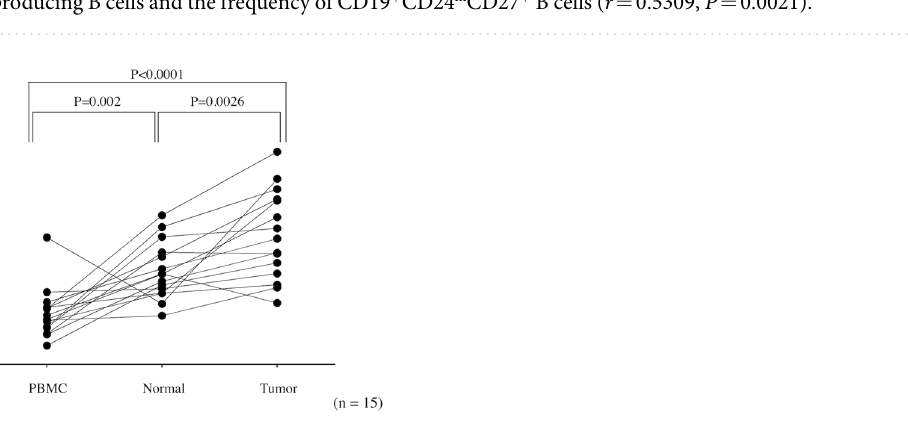
Figure 3. ( A ) Representative image of the frequency of regulatory B cells according to CD24 and CD27 expression in gastric cancer patients. ( B ) The frequency of IL-10-producing B cells in (a) CD19 + CD24 - CD27 - B cells, (b) CD19 + CD24 - CD27 + B cells, (c) CD19 + CD24 + CD27 − B cells, and (d) CD19 + CD24 hi CD27 + B cells. ( C ) The frequency of IL-10-producing B cells was significantly higher in the CD19 + CD24 hi CD27 + B cell subset than in other subsets ( P < 0.0001). ( D ) A significant positive correlation was detected between the frequency of